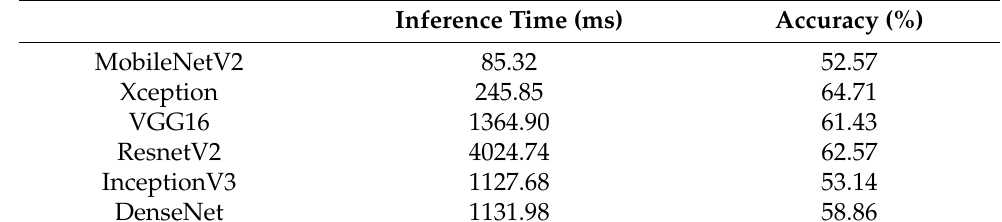
Table 5. Benchmark of CNN architectures.